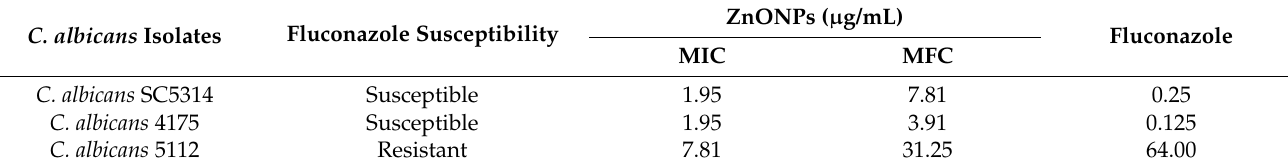
Table 3. MIC and MFC values of bio-fabricated ZnONPs against Candida albicans